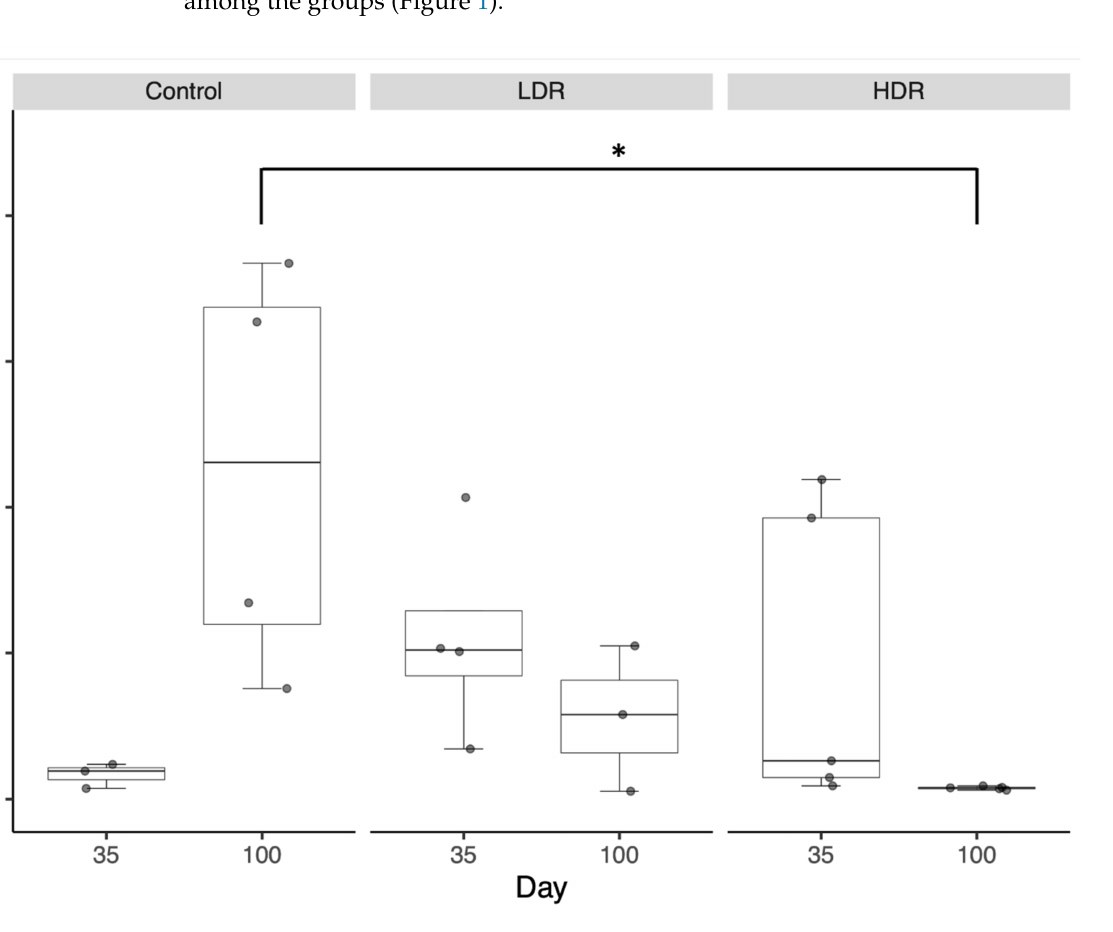
Figure 1. Radiation-induced changes in global DNA methylation patterns in the testis. ∗ Significant difference at p < 0.01. Sample medians are shown by the center line and crosses, respectively. Box edges represent the 25th and 75th